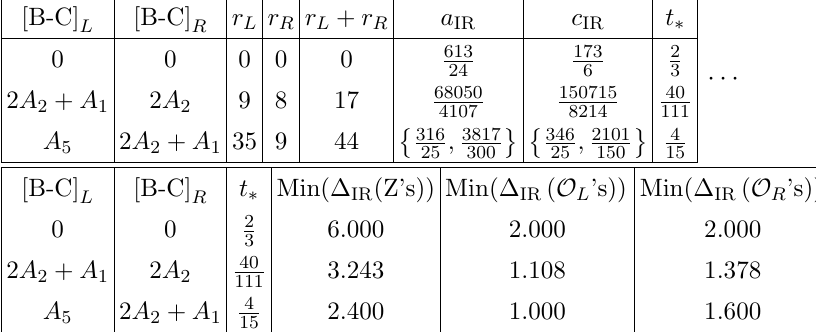
Table 17. Plain nilpotent mass deformations of ( E 6 , E 6 ) conformal matter, only rational